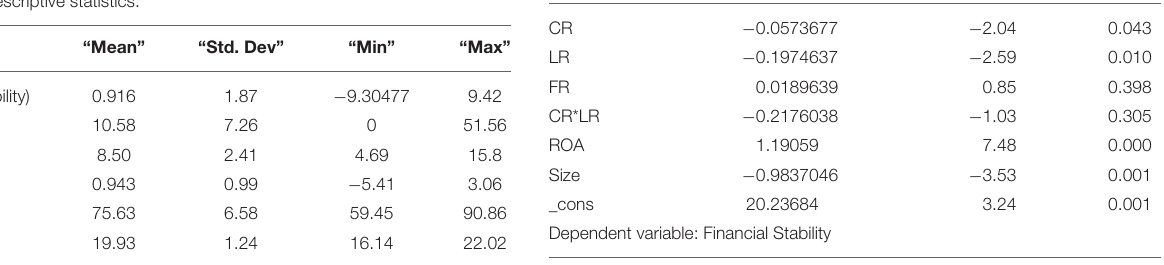
TABLE 2 | Descriptive statistics.